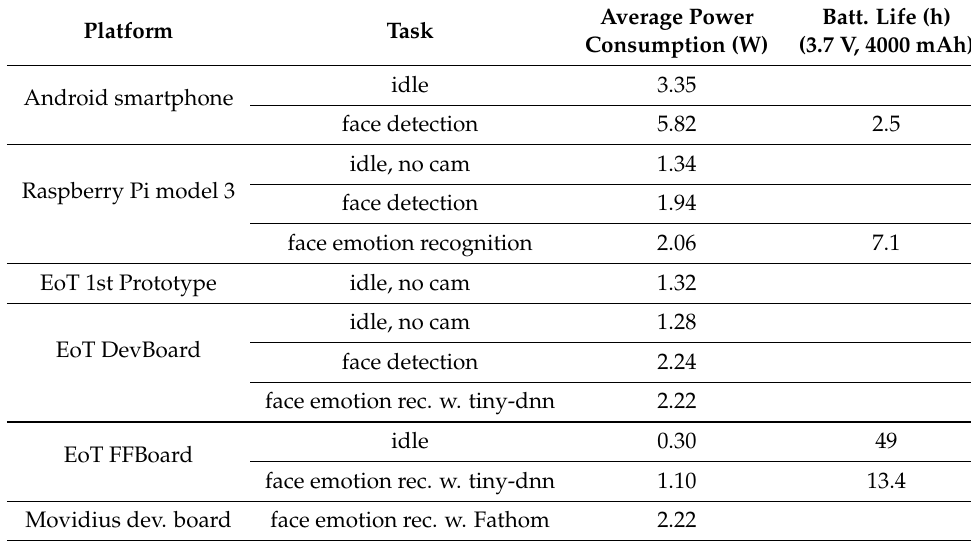
Table 3. Qualitative power consumption measures. All radio communication components were deactivated in the cases shown, except for the EoT Form-Factor Board (FFBoard). Both EoT DevBoard and Movidius devel. board used the IMX208 camera (see Figure 8). The Fathom case used only 4 of the 12 SHAVEs available and half precision. Smartphone model: Xiaomi